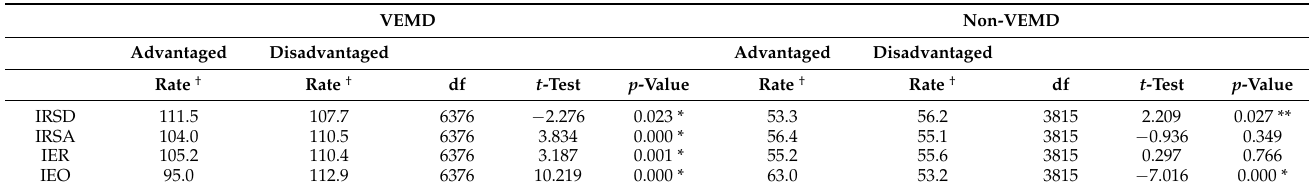
Table 4. Injury differences between Advantage and Disadvantage that attend VEMD and Non-VEMD reporting hospitals. VEMD Non-VEMD Advantaged Disadvantaged Advantaged Disadvantaged